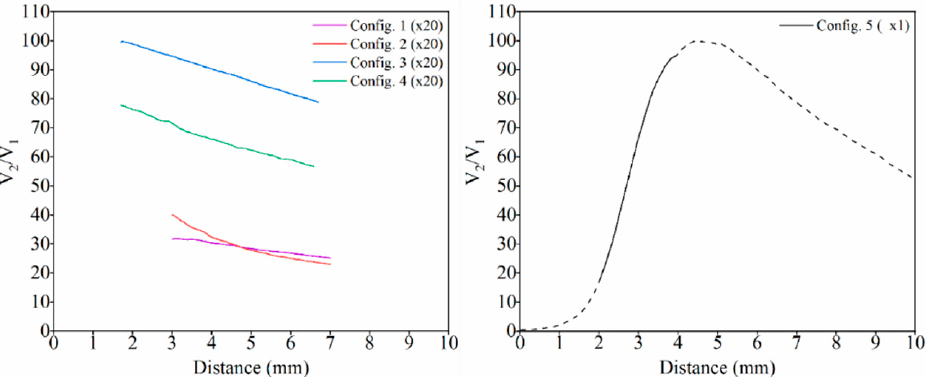
Figure 5. Response curves for different sensor configurations. On the left, for the fifth configuration (Config. 5), the complete calibration curve is shown as a dashed line, and the front slope is highlighted as a solid line. On the right, the back slopes of the rest of the configurations are shown magnified 20 times.